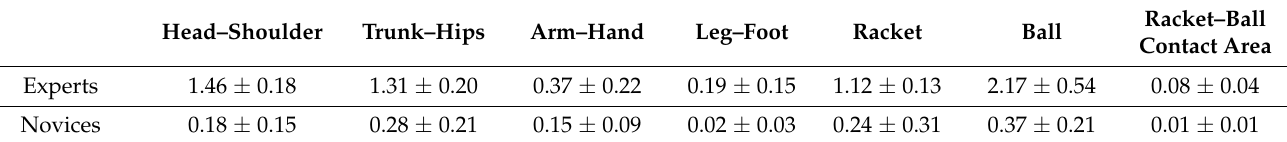
Table 2. Backhand gaze time (average and standard deviation) for tennis players of different skill levels.